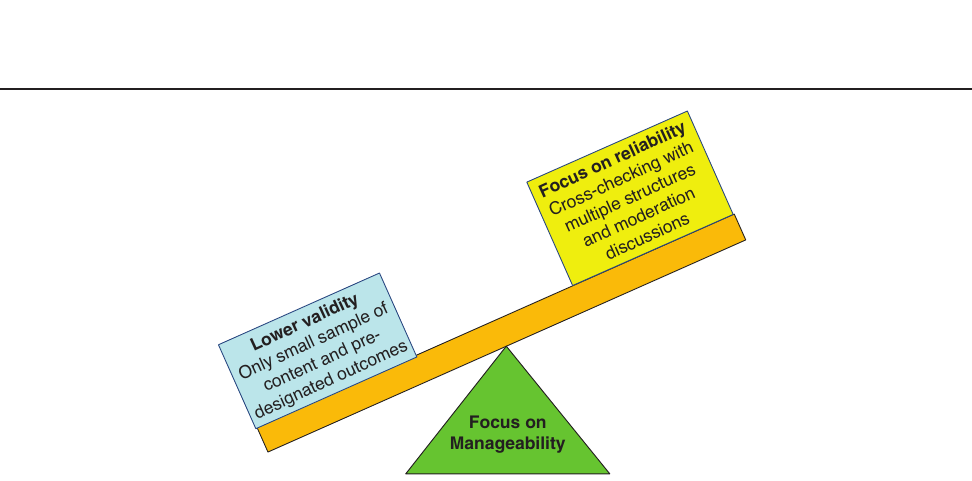
Figure 2: Phase 2 summative teacher assessment seesaw: Focus on reliability and